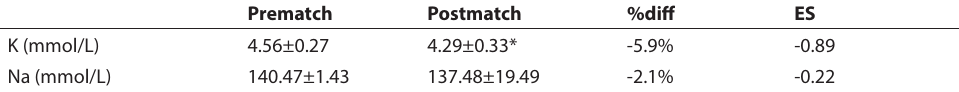
TABLE 2 Electrolyte values of the players before and after the played match. Data are presented as Mean ±